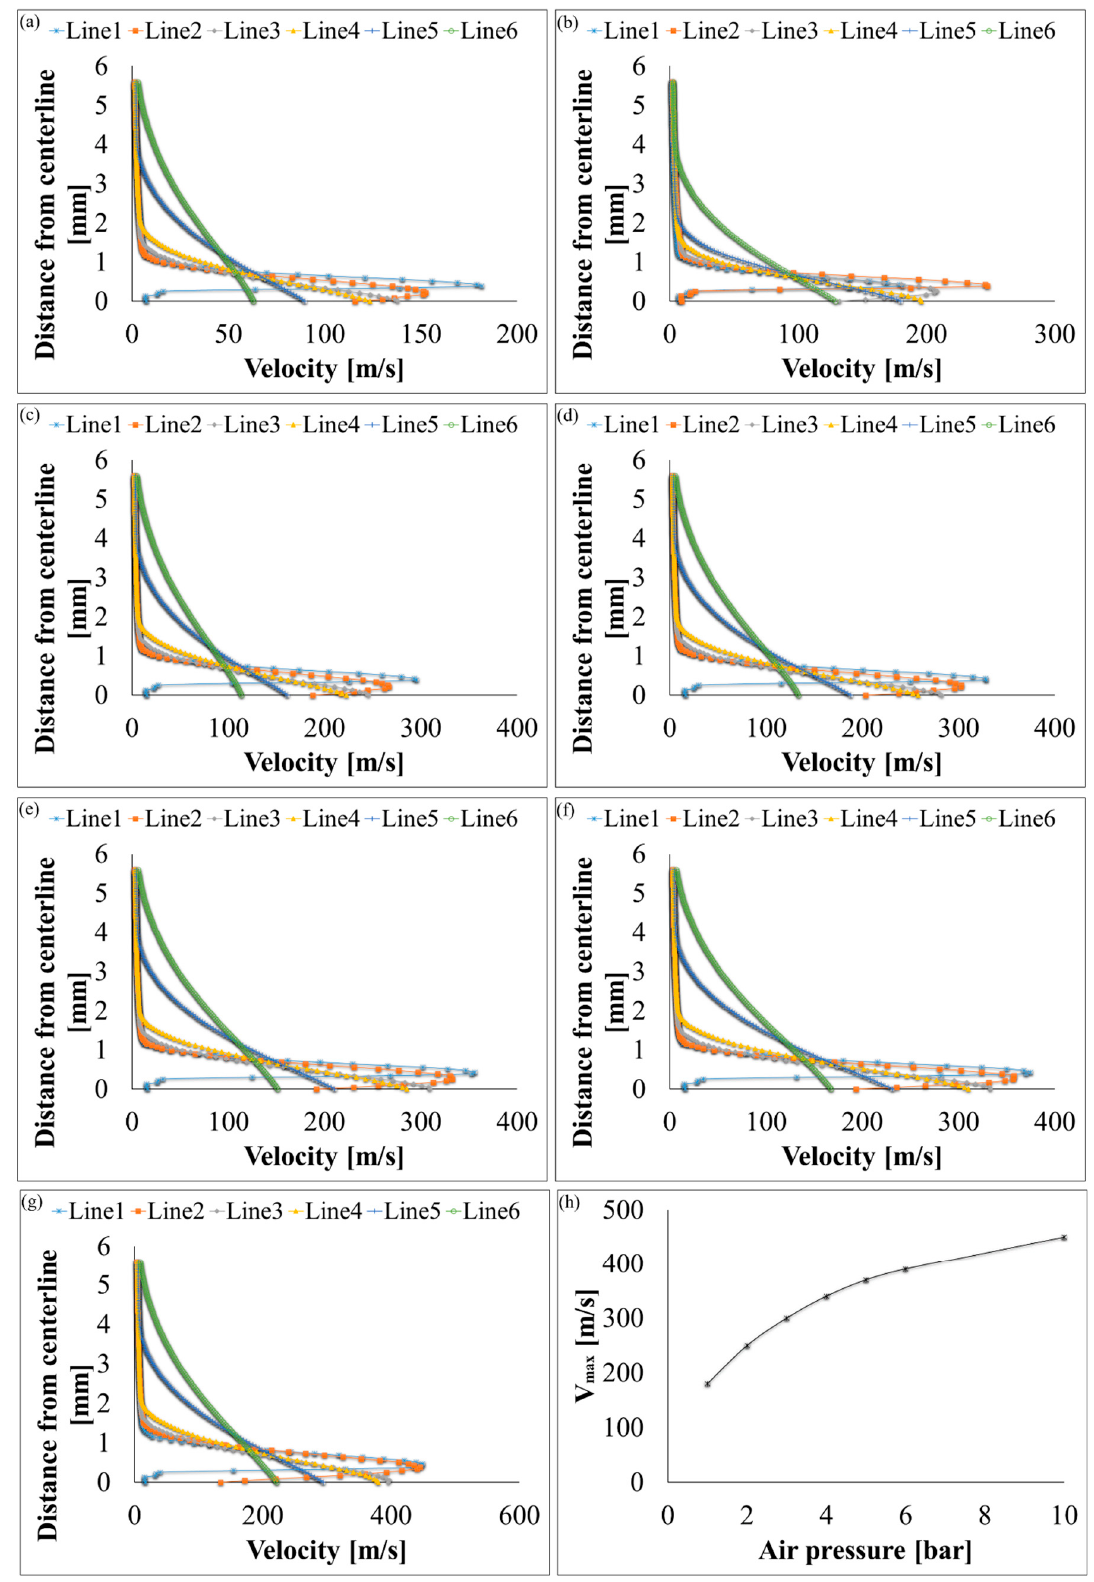
Figure 9. Velocity profiles at six vertical slices (at distance of 0, 1, 4, 6, 16, and 26 mm from the air outlet) for k- ε turbulence flow plots through SBS nozzle at different air pressures: ( a ) 1 bar, ( b ) 2 bar, ( c ) 3 bar, ( d ) 4 bar, ( e ) 5 bar, ( f ) 6 bar, ( g ) 10 bar, and ( h ) maximum velocity values at different air pressures.